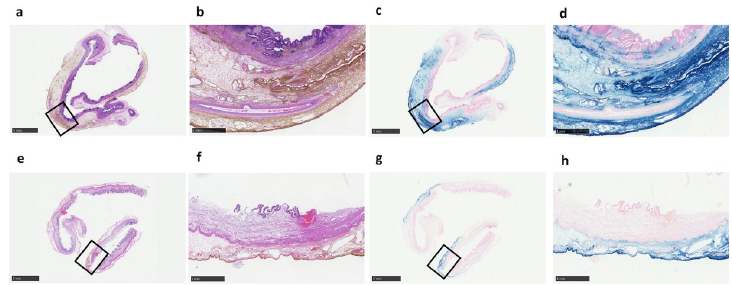
Fig 5. Histological examination of the gallbladder from wild-type swine in laparoscopic surgery. ( a, b ) Haematoxylin and eosin staining and ( c, d ) iron staining (Perl’s Prussian blue) of the gallbladder of swine with a superparamagnetic iron oxide (SPIO)-positive sentinel lymph node (SLN). ( e, f ) Haematoxylin and eosin staining and ( g, h ) iron staining of the gallbladder of the SLN SPIO-negative swine (Swine 3). Scale bar = 5 mm ( a, c, e, g ) and 1 mm ( b, d, f, h ).